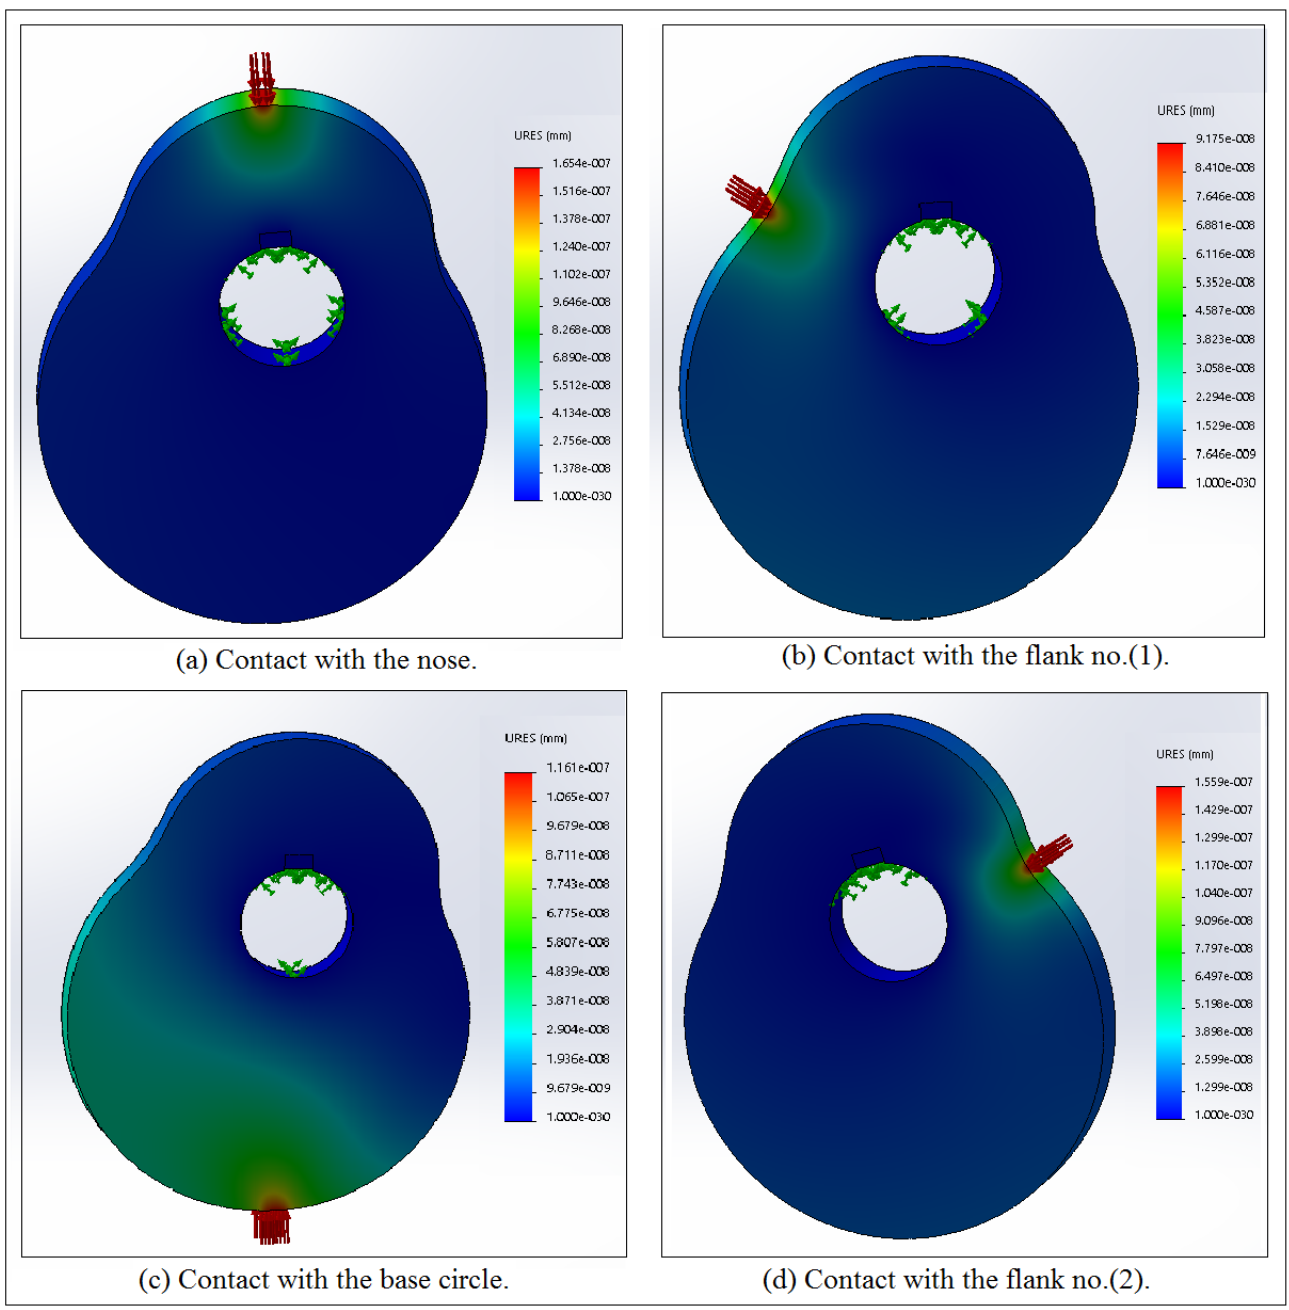
Figure 21. Bending deflection mapping contour for profile no.(2) at different contact locations.